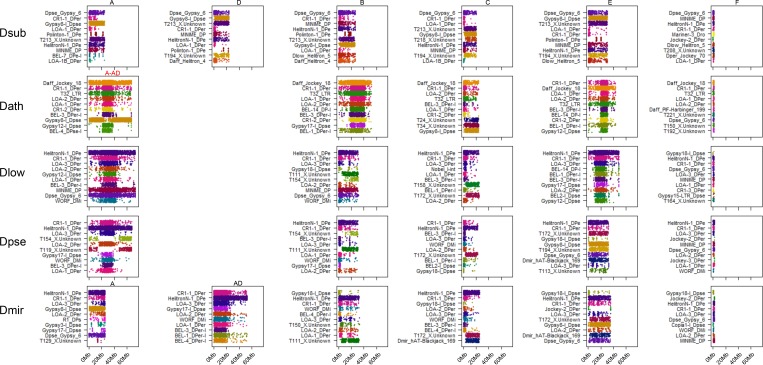
Genomic distribution of transposable elements by species and Muller element.The top 10 TE’s per Muller element, per species, are shown in descending order from top to bottom and ranked by their total contribution (bp) to each element. Each point represents a genomic location masked for an element.